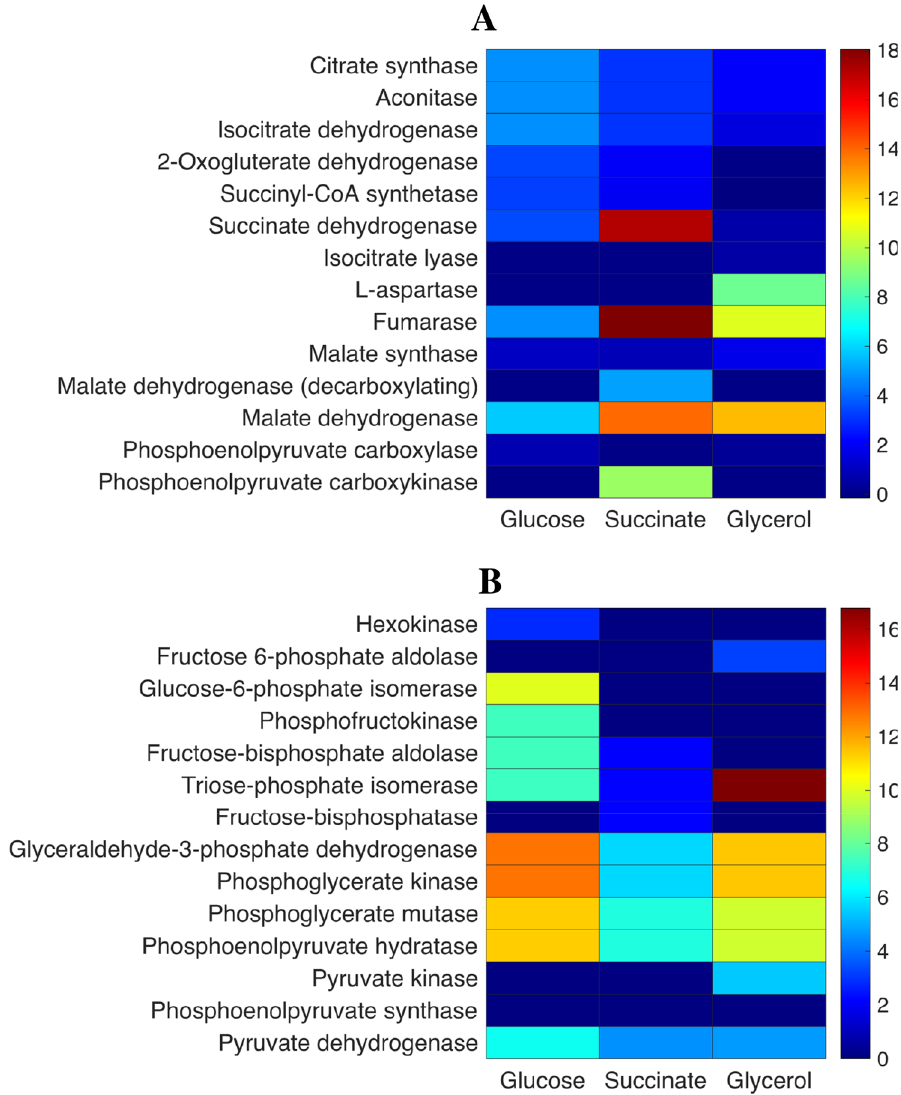
Figure 3. Flux balance analysis of TCA cycle and anaplerotic reactions of the TCA cycle ( A ) along with glycolysis/gluconeogenesis ( B ) pathways predicted by iEco-F420 metabolic model of E. coli for independent simulations using glucose, glycerol, or succinate as sole carbon sources (60 C-mol of carbon source). Objective is maximizing F 420 production while maintaining growth at 30% of its max. Maintenance ATP requirements is fixed at 5.17 mmol/g DCW. Colormap shows absolute flux values in mmol/gDCW/hr. Fructose-bisphosphate aldolase, Triose-phosphate isomerase, Glyceraldehyde-3-phosphate dehydrogenase, and phosphoenolpyruvate hydratase are active in favor of gluconeogenesis pathway with succinate as the carbon